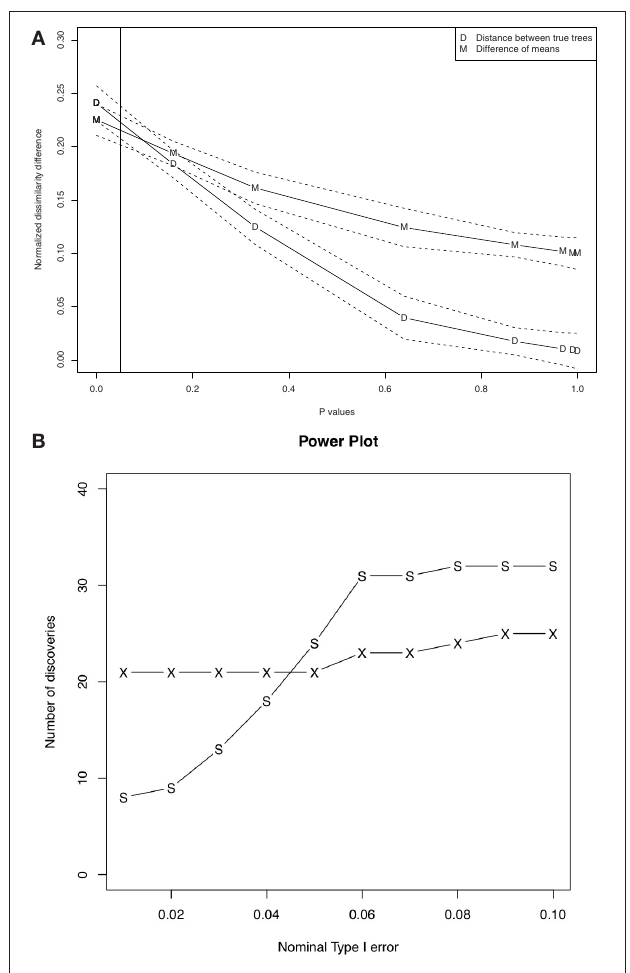
Figure 3 | (a) Correlation between p-values and dissimilarity map distances, for the data sets. For each data set, the plotted “D” point represents the distance between the true trees  , and the plotted “M” point represents the distance between the posterior means   E given the sequence data. The number of data sets is 84. For more details see the Supplementary Material. We fitted the data in R (R Development Core Team, 2004) using loess for local regression. The dotted lines are for 95% confidence intervals of the fitted lines. The vertical solid line is the p -value cutoff α = 0.05. (B) Power comparison of our method vs. the “paired SH test” described in the main text. The “X” line plots the number of discoveries for our method; the “S” line is for the SH